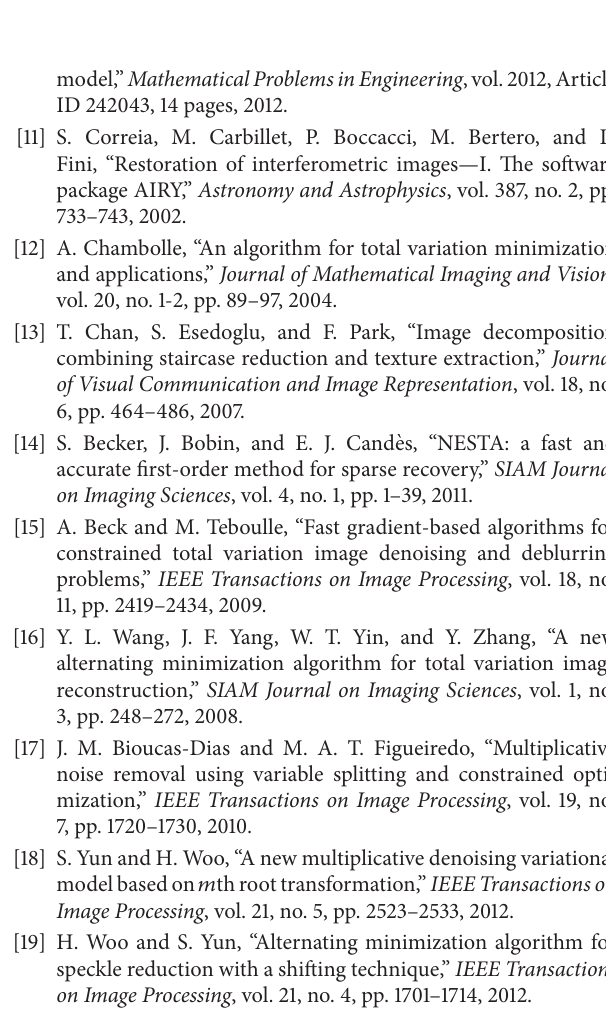
Figure 5: Results of different methods for Example